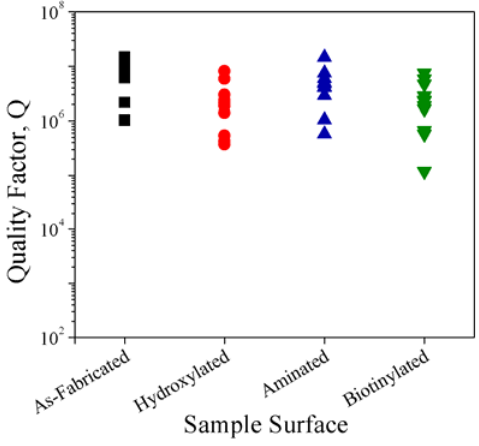
Figure 9. Effect of surface functionalization on the quality factor of the microtoroids at each reaction step.